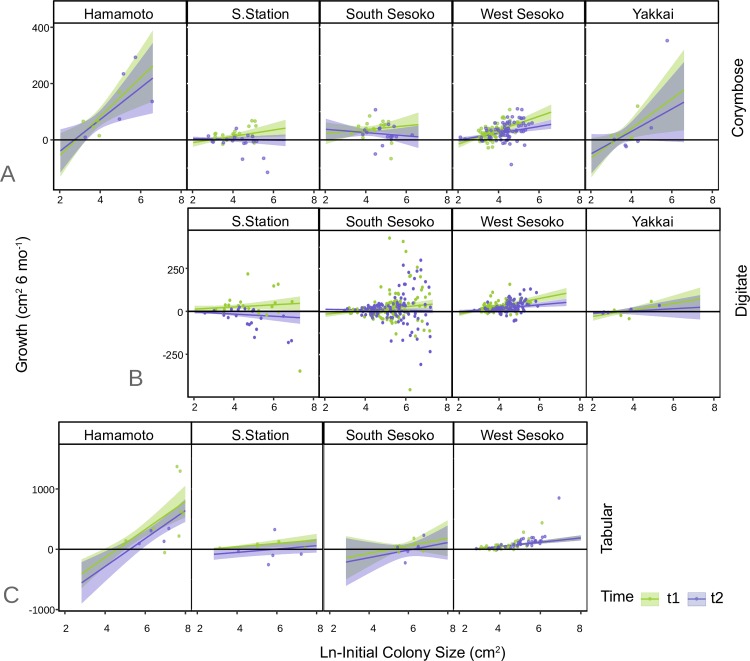
Initial size and growth relationship.Spatio-temporal variation in initial size and growth relationship of corymbose (A), digitate (B), and tabular (C) colonies. Line represents predicted slopes and 95% confidence intervals at different time periods.